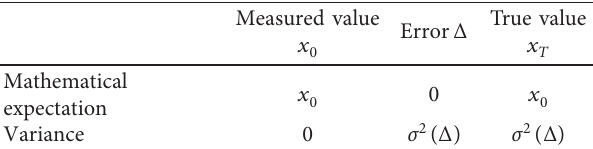
Table 3: The probability expression of the true value, measured value, and